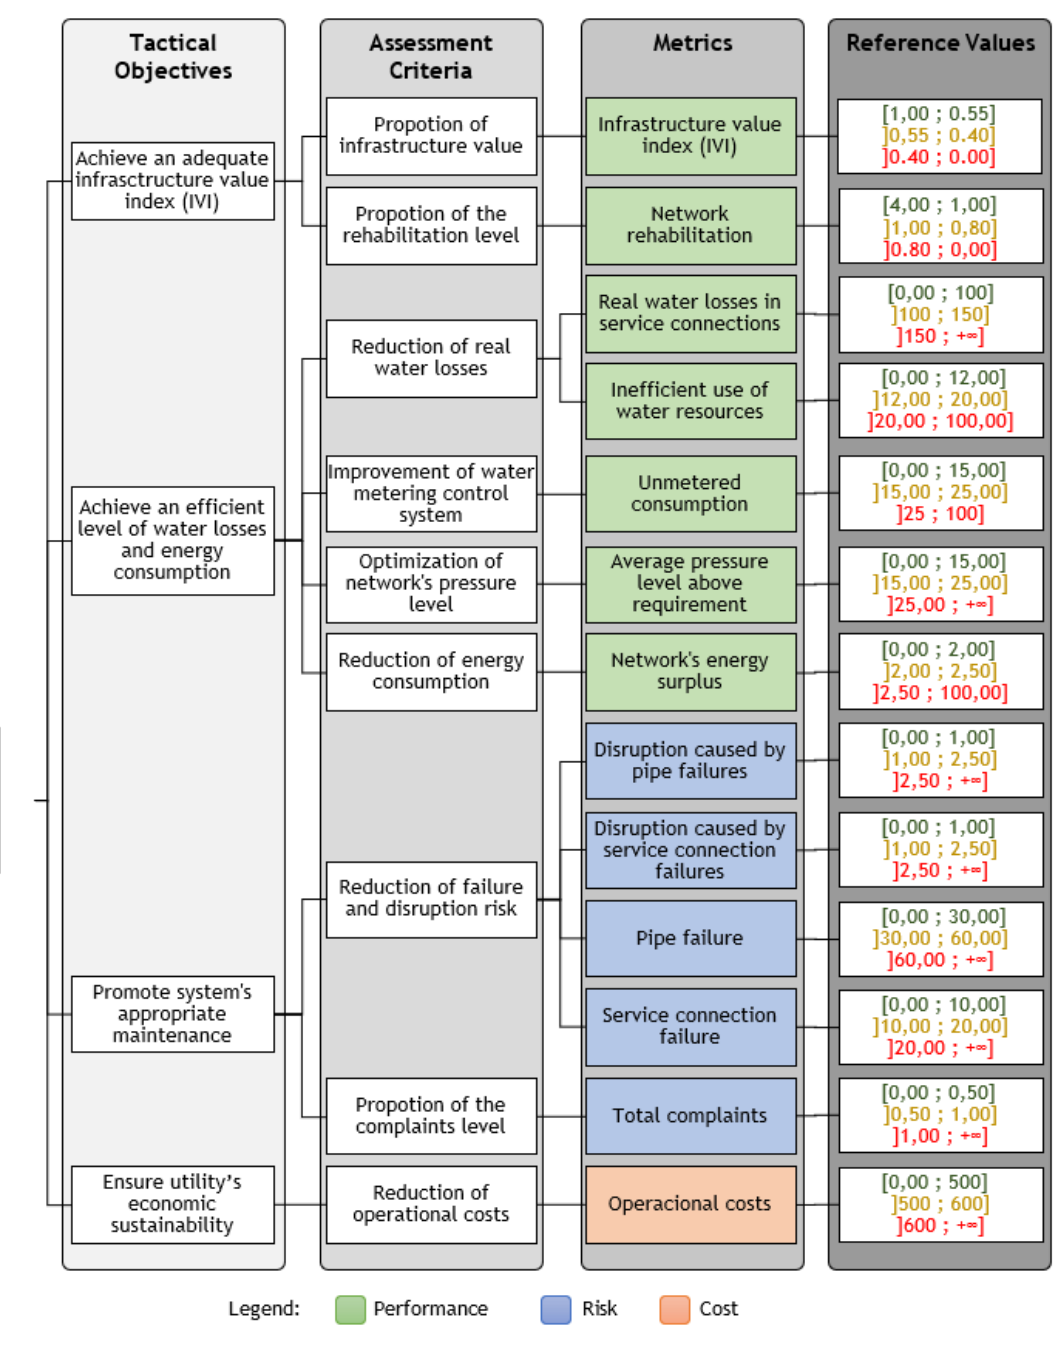
stress, since they represent an amount of water that is Real water losses in service connections (P3) and Inef- extracted, treated and pumped, without, however, being ficient use of water resources (P4) . Real water losses are the physical losses of water from the distribution system used. The real water losses volume was obtained through up to the point of customer metering, including leakages the system’s water balance, described in ERSAR’s techni- caused by fissures in pipes and service connections as well cal guide [9] and in accordance with the recommendations as storage tank overflows. These losses inflate water util- of the International Water Association. The P3 indicator is ity’s production costs, putting water resources at greater given by the ratio between the real water losses and the